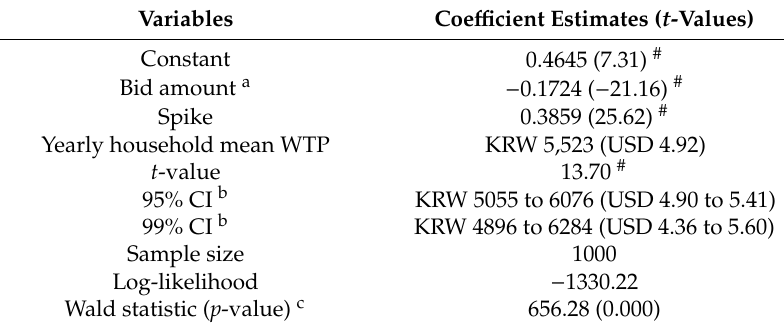
Table 2. Estimation results of the model and the mean willingness to pay